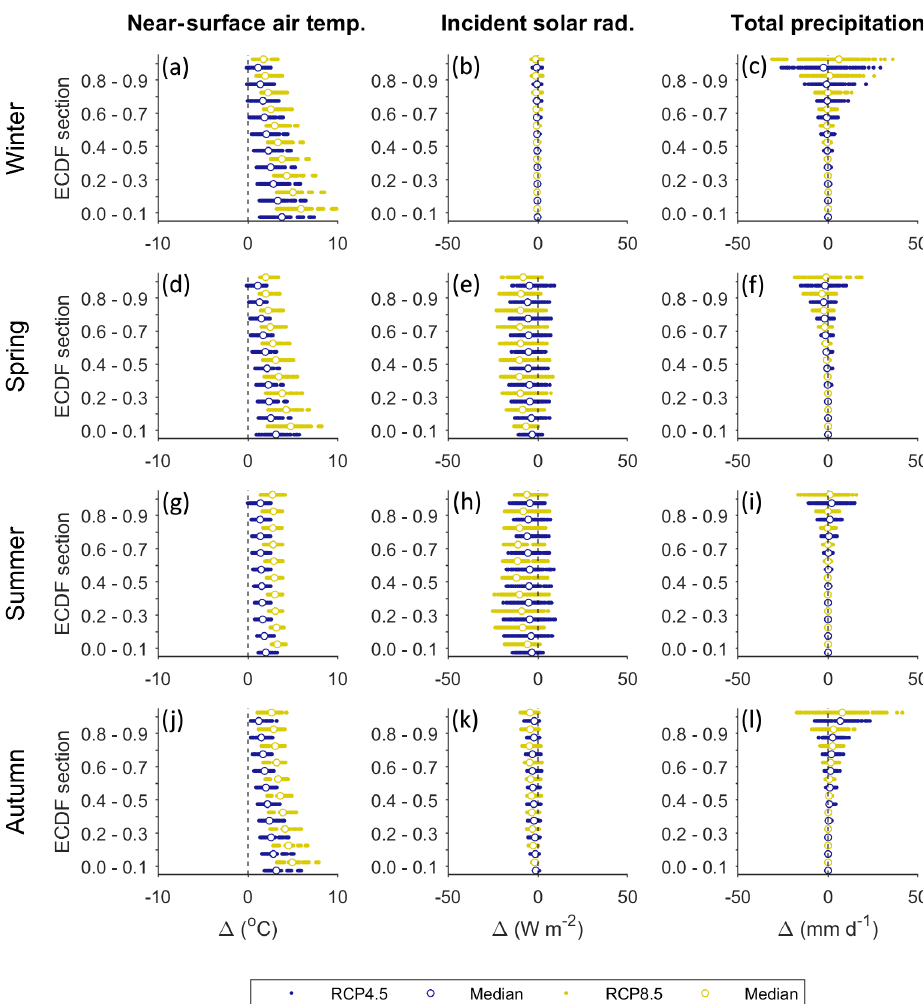
Figure 5. Seasonal average projected changes in ECDFs for near-surface air temperature (a, d, g, j) , incident solar radiation (b, e, h, k) , and total precipitation (c, f, i, l) for the late 21st century (2076–2100) relative to the recent past (1981–2005). Changes are plotted for each 10% section of the ECDFs. For each section, blue and yellow dots represent each of the 140 downscaled future climate time series for the RCP4.5 and RCP8.5 ES respectively (280 in total). Winter: Dec, Jan, Feb; spring: Mar, Apr, May; summer: Jun, Jul, Aug; autumn: Sep, Oct,